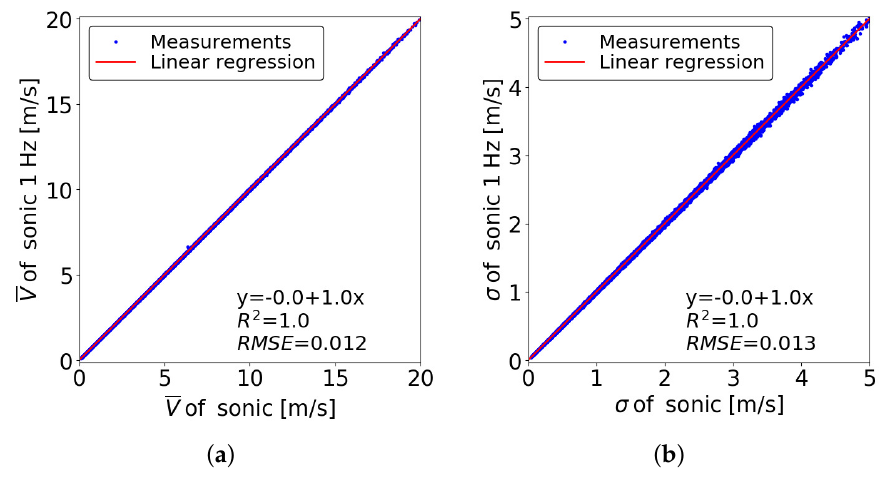
Figure 8. Comparison of the original sonic anemometer data collected at a sampling frequency of 10 Hz and the sonic anemometer data re-sampled at 1 Hz sampling frequency. The measurement height is 40 m. ( a ) 10-min average horizontal wind speeds and ( b ) standard